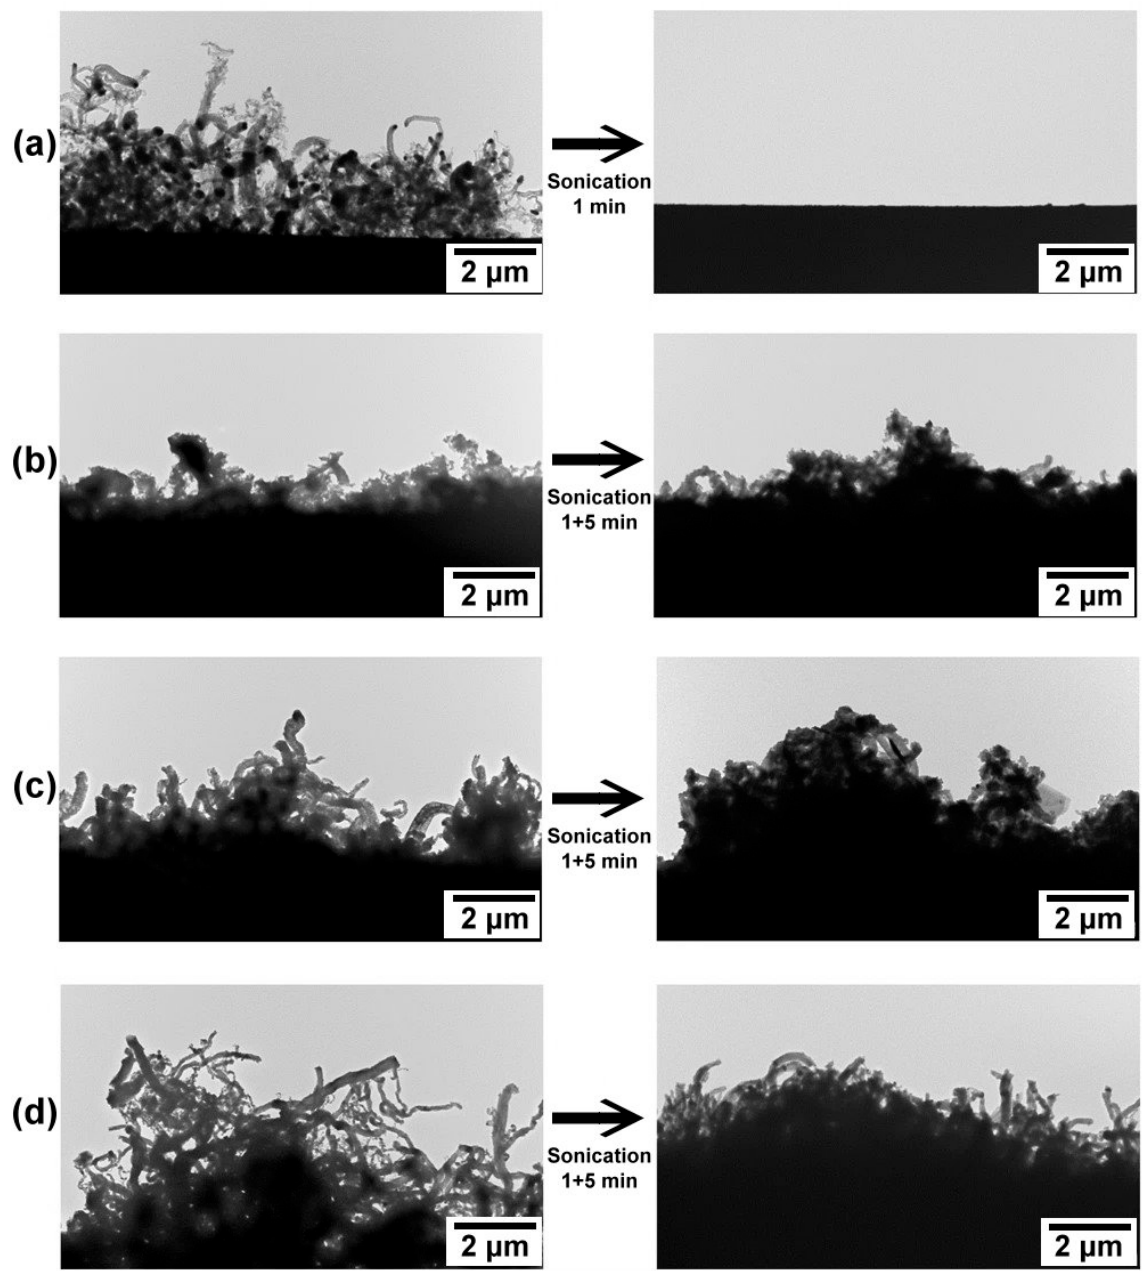
Figure 6. TEM images of the surface of modified microfibers before and after sonication treatment procedure: ( a ) CNF/FGC; ( b ), ( c ) CNF/CMF; ( d ) CNF/BMF. Note that the same areas of the fiber’s surface are compared.